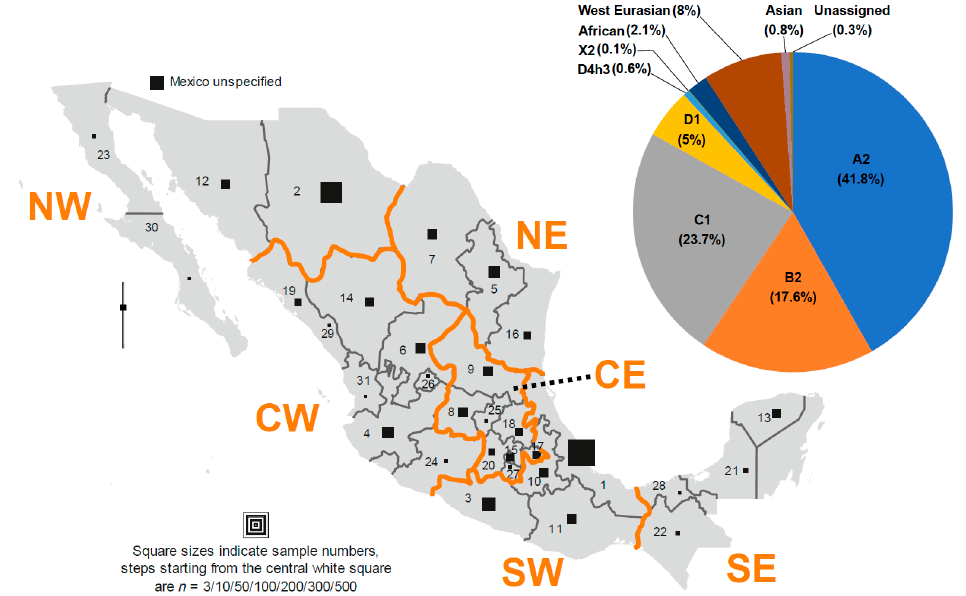
Figure 1. TMA geographic origin and haplogroup classification of the 2021 Mexican individuals. The main figure shows the administrative units of Mexico and the samples from each of the units analyzed in this study. The administrative units are numbered according to Table S1. The geographic subsets indicated by orange lines and text are Northwest (NW), Northeast (NE), Center-West (CW), Center-East (CE), Southwest (SW), and South-East (SE). The pie chart shows the proportions of Indigenous American haplogroups and other contributions to the Mexican mtDNA pool. See text for